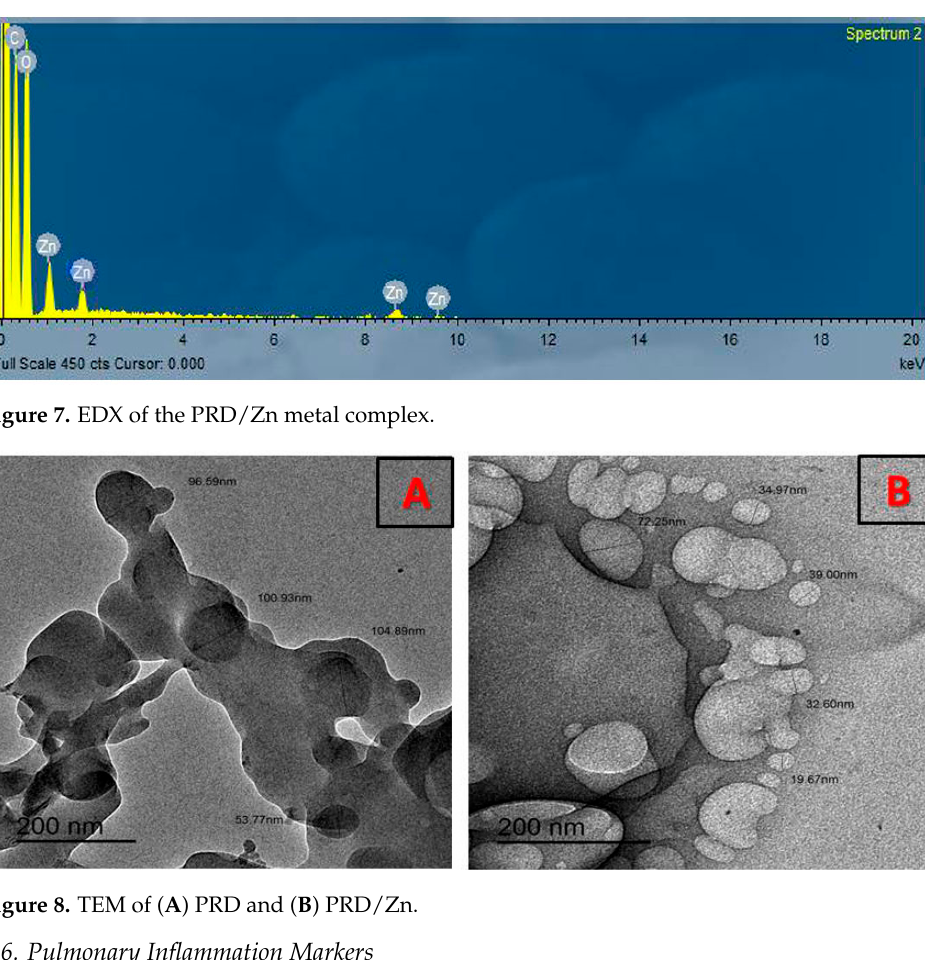
Figure 6. SEM of ( A ) PRD and ( B ) PRD/Zn.